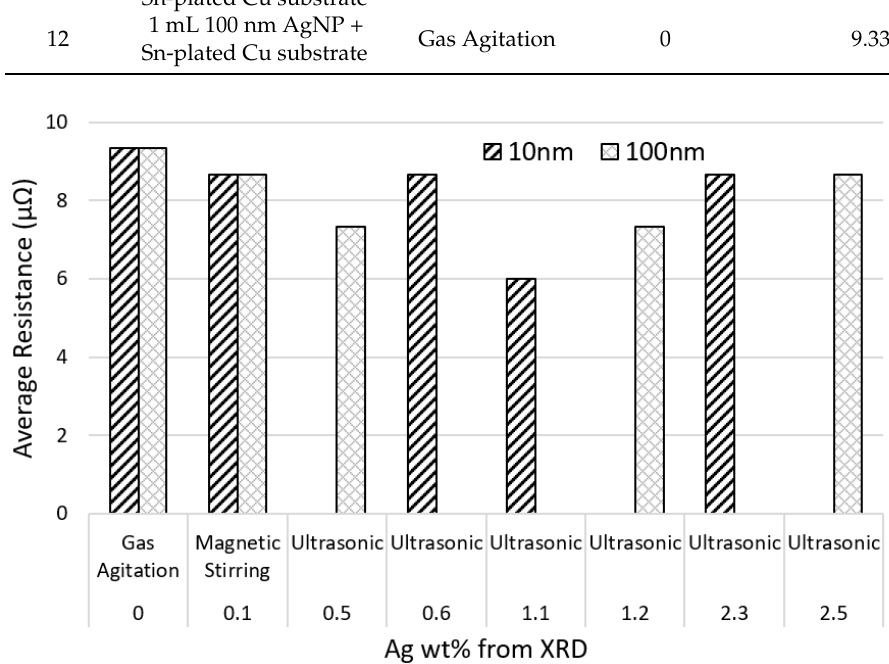
Figure 19. Coating layer using different dispersion methods: ( a ) Ultrasonic agitation ( b ) Magnetic stirring ( c ) Argon gas agitation (10 nm AgNP sample) .